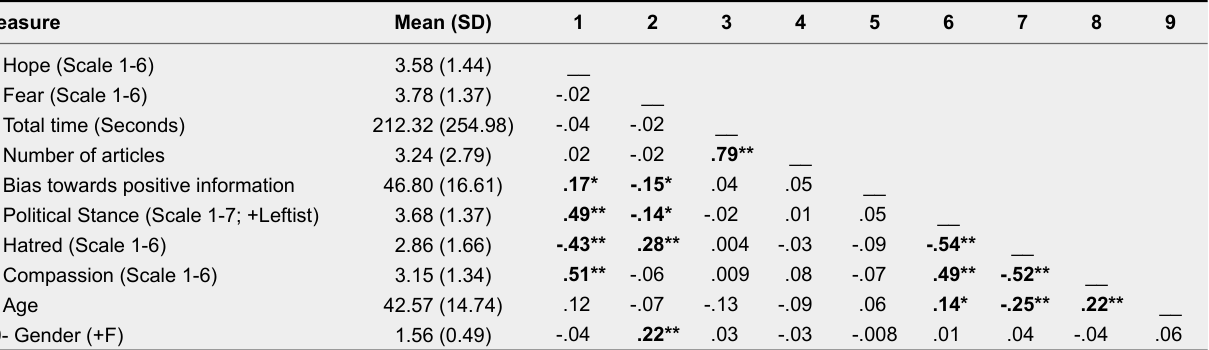
Correlations Between Research